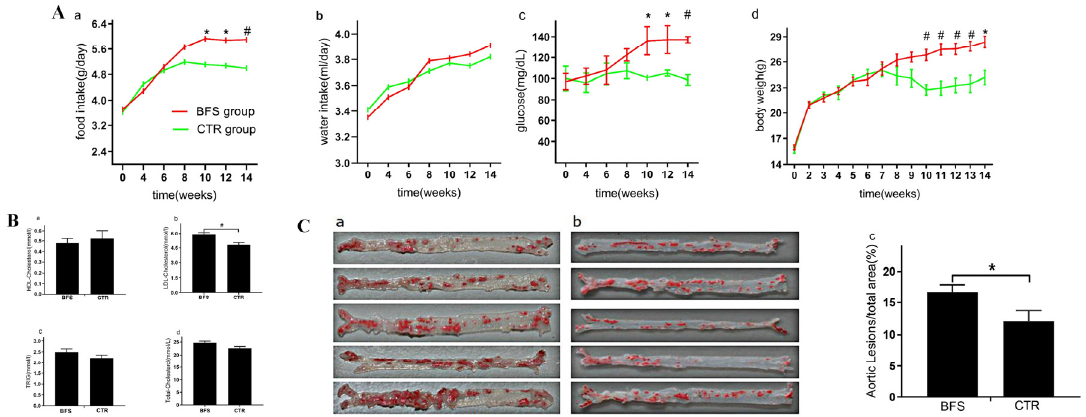
Figure 1. The differences of food intake, glucose, body weight, and lipid level between B. fragilis and control groups. ( A ) (a–d): Food intake, water intake, fasting blood glucose, and body weight varied with age. ( B ) (a–d): Effect of Bacteroides fragilis supplementation (BFS) on blood lipid in -/- mice. ( C ) (a–c): Gross Oil Red O staining and atherosclerotic lesion area of aorta surface in each group. ( C ) (a): The atherosclerosis lesion in BFS group. ( C ) (b): The atherosclerosis lesion in CTR group (control group). * p < 0.05, # p < 0.01 compared with the CTR group.